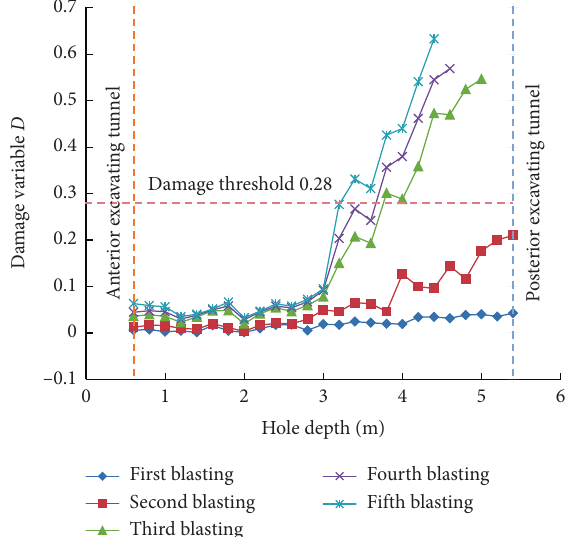
Figure 7: Relation curves between damage variable and hole depth ( L 1).